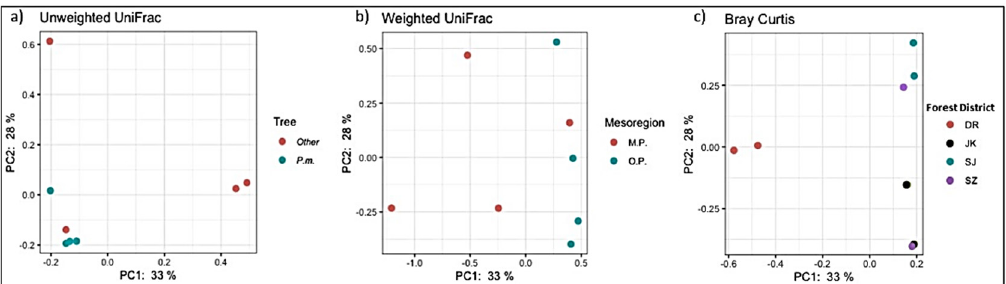
Figure 6. Graphical results of microbiome beta biodiversity analysis: ( a ) for trees, where P.m.— Pseudotsuga menziesii and other–tree of adjacent tree species, ( b ) for mesoregions, where M.P.—Masurian Plain and O.P.—Olsztynek Plain, ( c ) for Forest Districts (abbreviations—see Table 1).